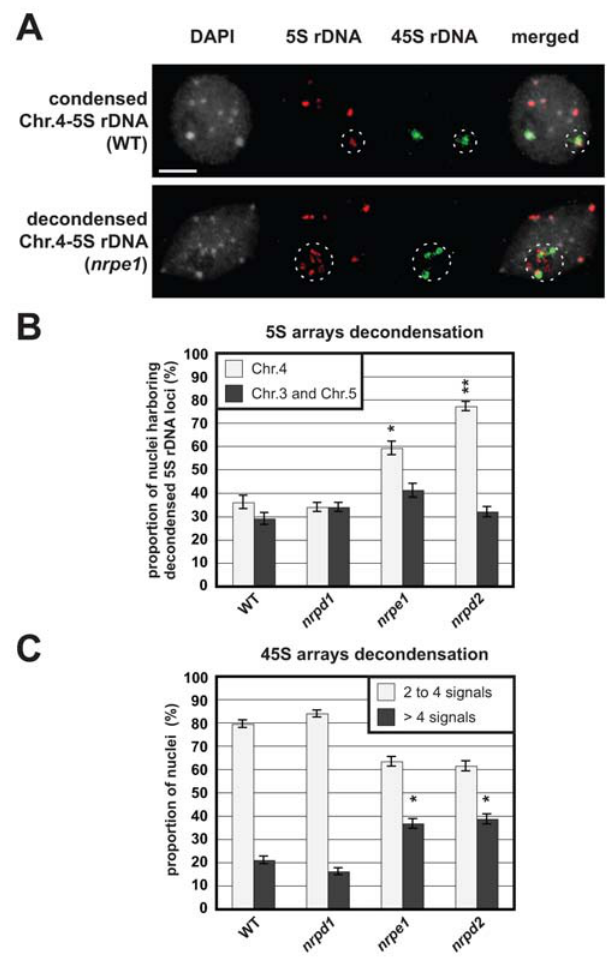
Figure 3. Compaction of rDNA arrays. (A) Representative images of condensed and decondensed 5S rDNA locus from chromosome 4. Counterstaining with DAPI (left); FISH with a 5S rDNA probe (red); FISH with a 25S rDNA probe which reveals the 45S locus (green); and the merged image on nuclei from WT and nrpe1 nuclei. Associated 5S and 45S rDNA loci from chromosome 4 are circled. In both cases (WT and nrpe1 ), 5S signals from the two chromosomes 4 are present in the white circle. Non circled 5S-red signals are from chromosomes 3 and 5. Bar=5 m m. B) Proportion of nuclei, derived from 45 to 62 nuclei analysed, harboring decondensed 5S signals. 5S signals from chromo- some 4 were analysed separately whereas 5S signals from chromo- somes 3 and 5 were considered together. Asterisks denote significant differences to the corresponding (chromosome 4 or 3 and 5) WT value. (Z-test, * P , 0,05 , ** P , 0,01). Interval confidence with a confidence level of 99% is shown on each bar. (C) The percentage of nuclei harboring 2 to 4 NOR loci (grey) and more than 4 NOR loci (black) was estimated from 45 to 62 nuclei analysed in WT, nrpd1 , nrpe1 and nrpd2 plants. Asterisks denote significant differences to the WT value. (Z-test,* P , 0,05). Interval confidence with a confidence level of 99% is shown on each